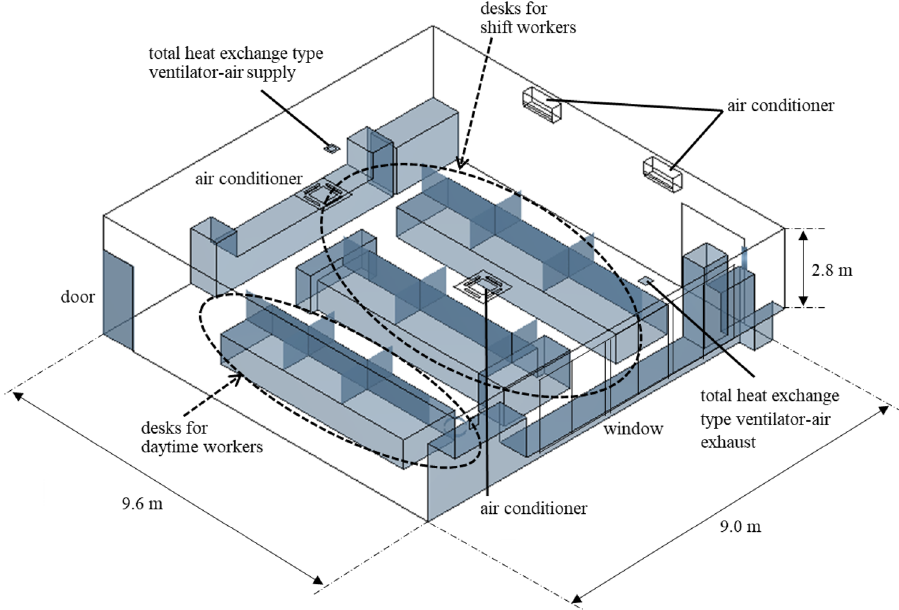
Figure 1. The layout of the workplace.